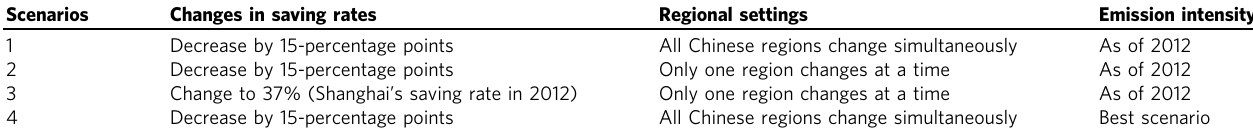
Table 1 Scenario settings in this